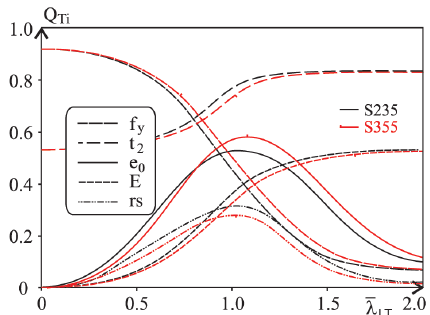
Figure 11. Total quantile contrast indices 62×46 mm (300×300